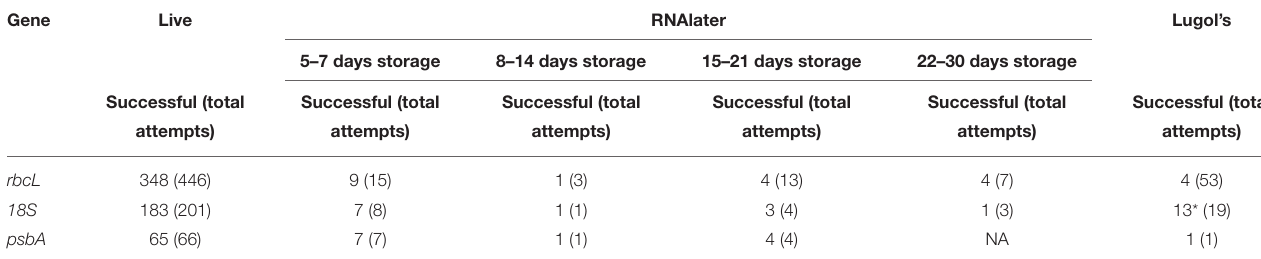
TABLE 5 | Amplification success rates for live, RNA later, and Lugol’s solution samples.